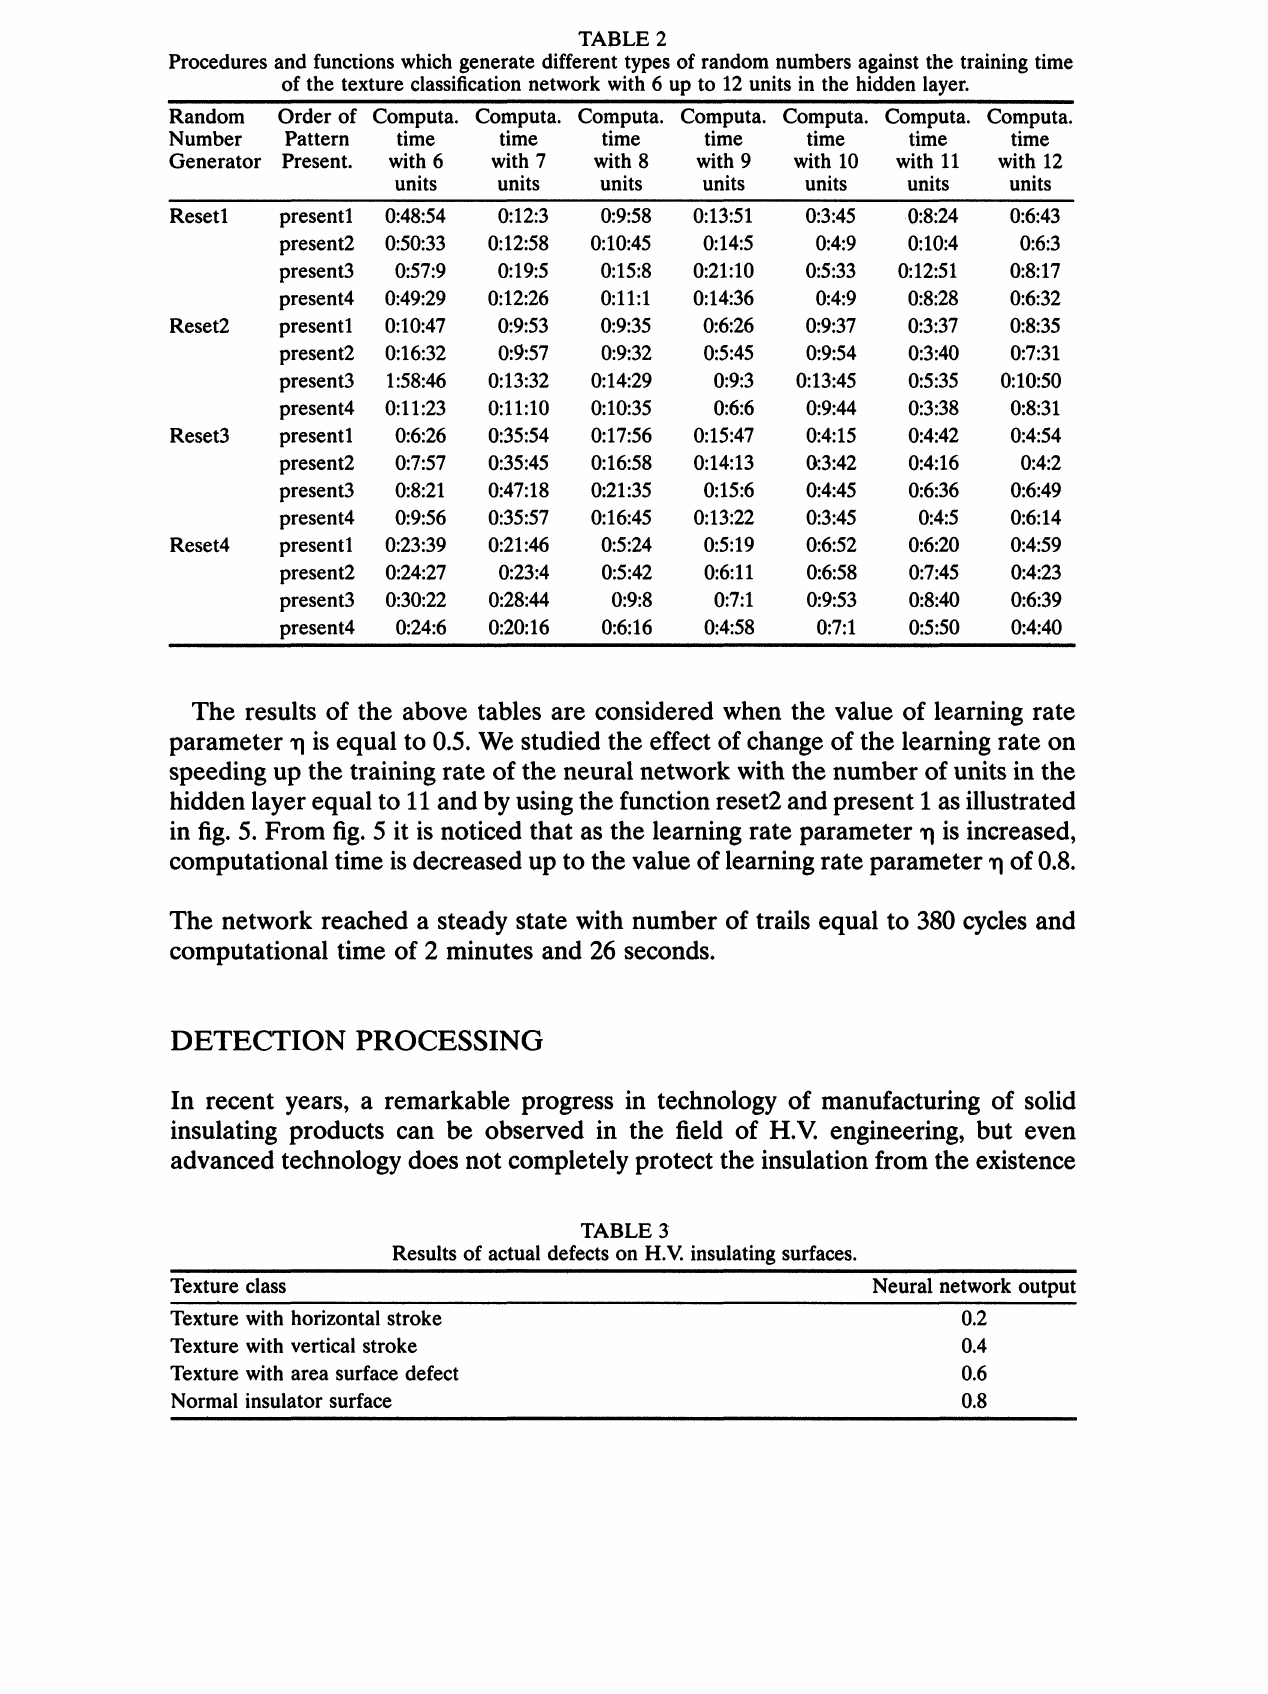
TABLE 2 Procedures and functions which generate different types of random numbers against the training time of the texture classification network with 6 up to 12 units in the hidden layer.